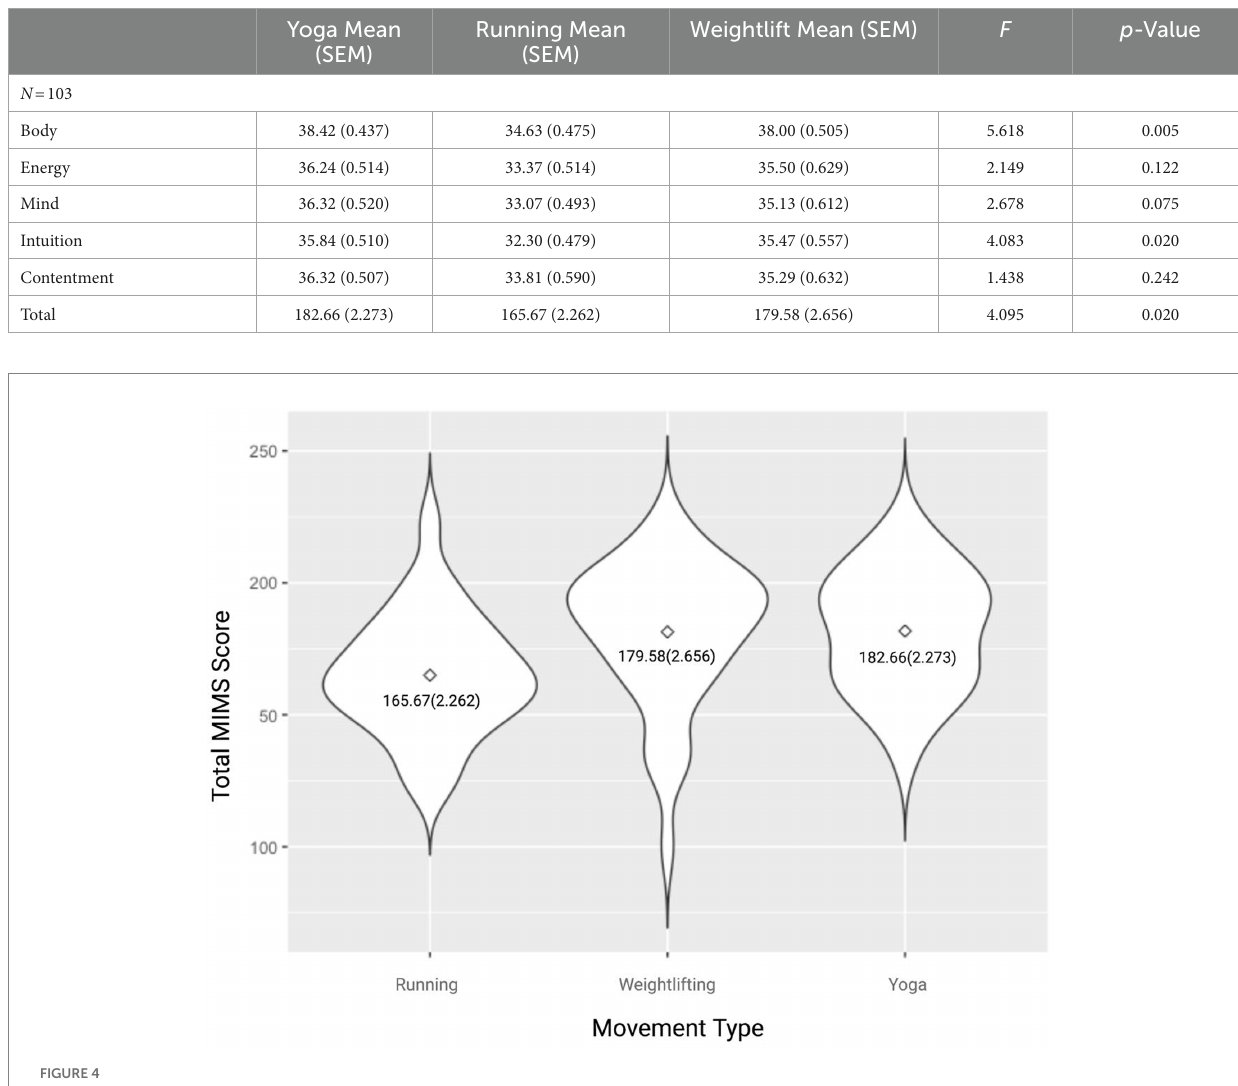
TABLE 4 Between group differences for yoga, running and weightlifting.